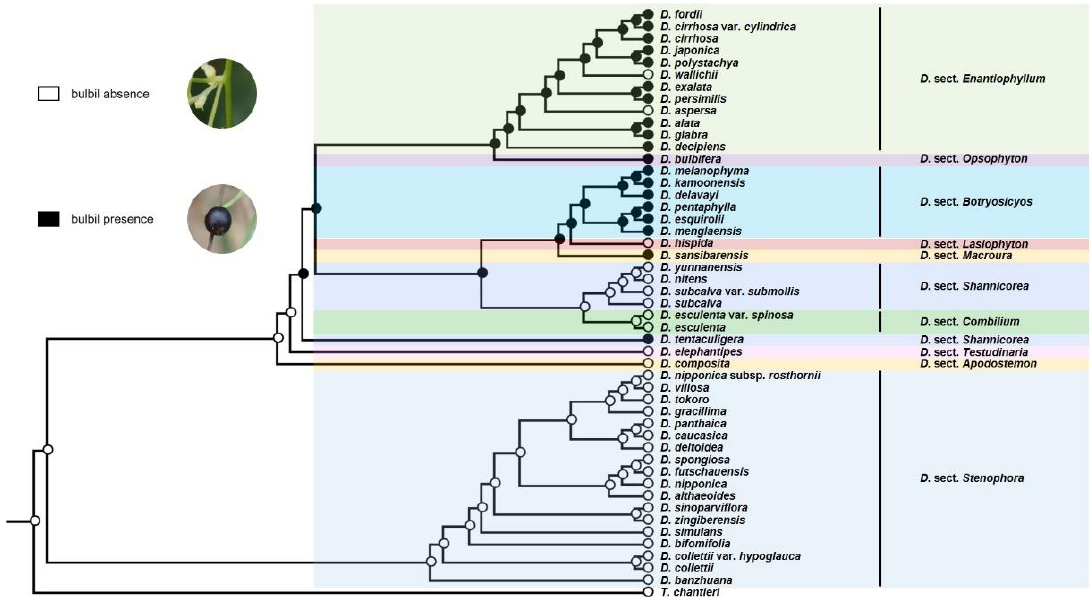
Figure 3. Ancestral character state reconstruction for bulbils using the parsimony method.